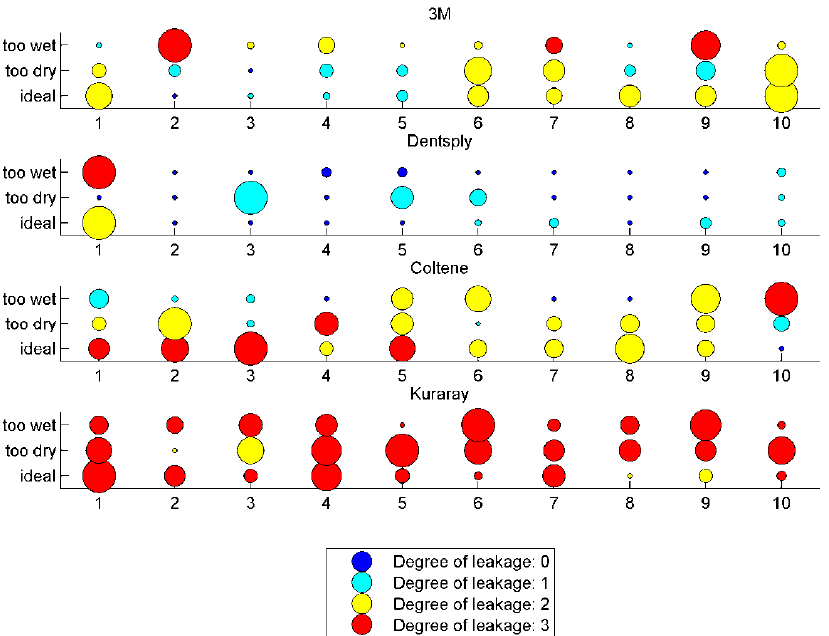
Figure 7. Summary of data: microleakage in micrometers/degrees of leakage (Dentsply “Prime and Bond Active”, 3M ESPE “Single bond”, Coltene “One Coat 7 Universal”, and Kuraray “Clearfil Universal Bond Quick”).